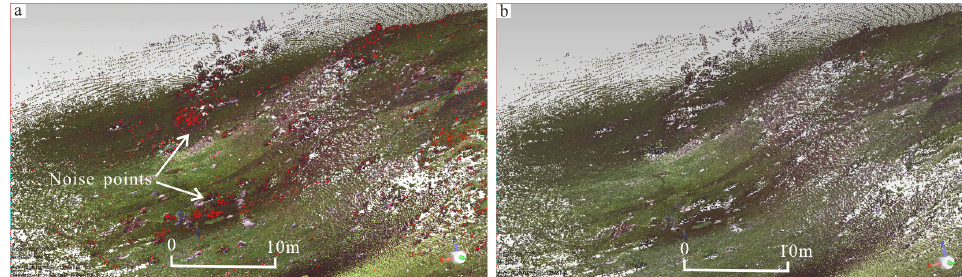
Figure 4. The filter processing of the point clouds. ( a ) The raw point clouds. The point clouds were filtered using the Geomagic Studio software. Red points are the noise points, such as vegetation, rocks and vehicles and so on. ( b ) The filtering results of the point clouds.